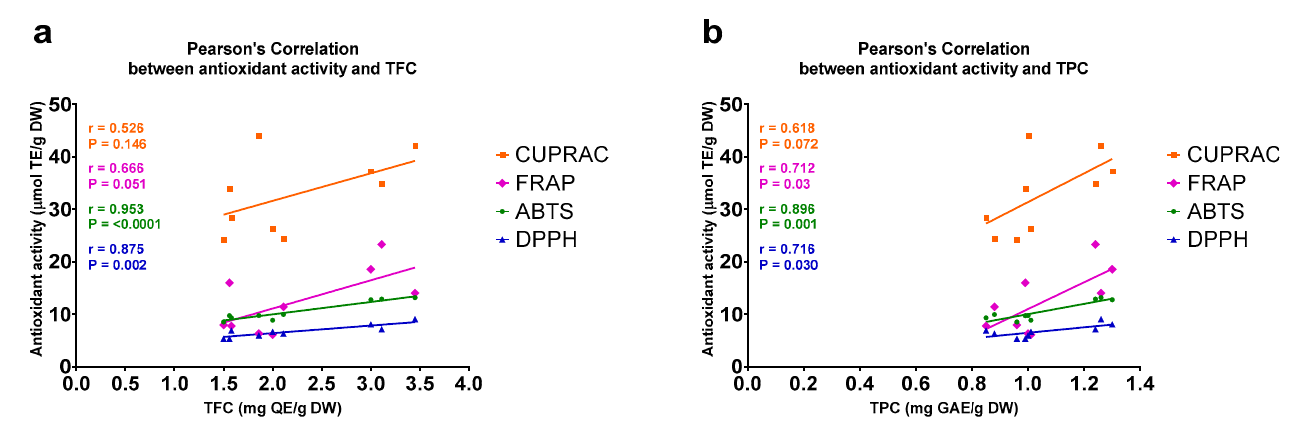
Figure 1. Scatter plot displaying Pearson’s correlations between antioxidant activities and ( a ) total flavonoid contents (TFCs) and ( b ) total phenolic contents (TPCs) of the methanol extracts of A. compactum that were generated by microwave-assisted extraction (MAE). The antioxidant activities of the extracts were measured by four independent assays. ABTS, 2,2 ′ -azino-bis(3-ethylbenzothia- zoline-6-sulfonate); CUPRAC, cupric ion reducing antioxidant capacity; DPPH, 2,2 ′ -diphenyl-1-pic- rylhydrazyl; DW, dry weight; FRAP, ferric reducing antioxidant power; GAE, gallic acid equivalent; QE, quercetin equivalent; TE, Trolox equivalent.